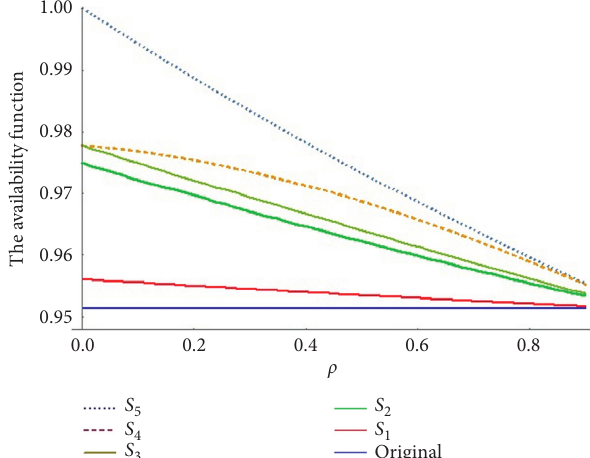
Table 2: The AEFs for a different set B and R,I ∈ S